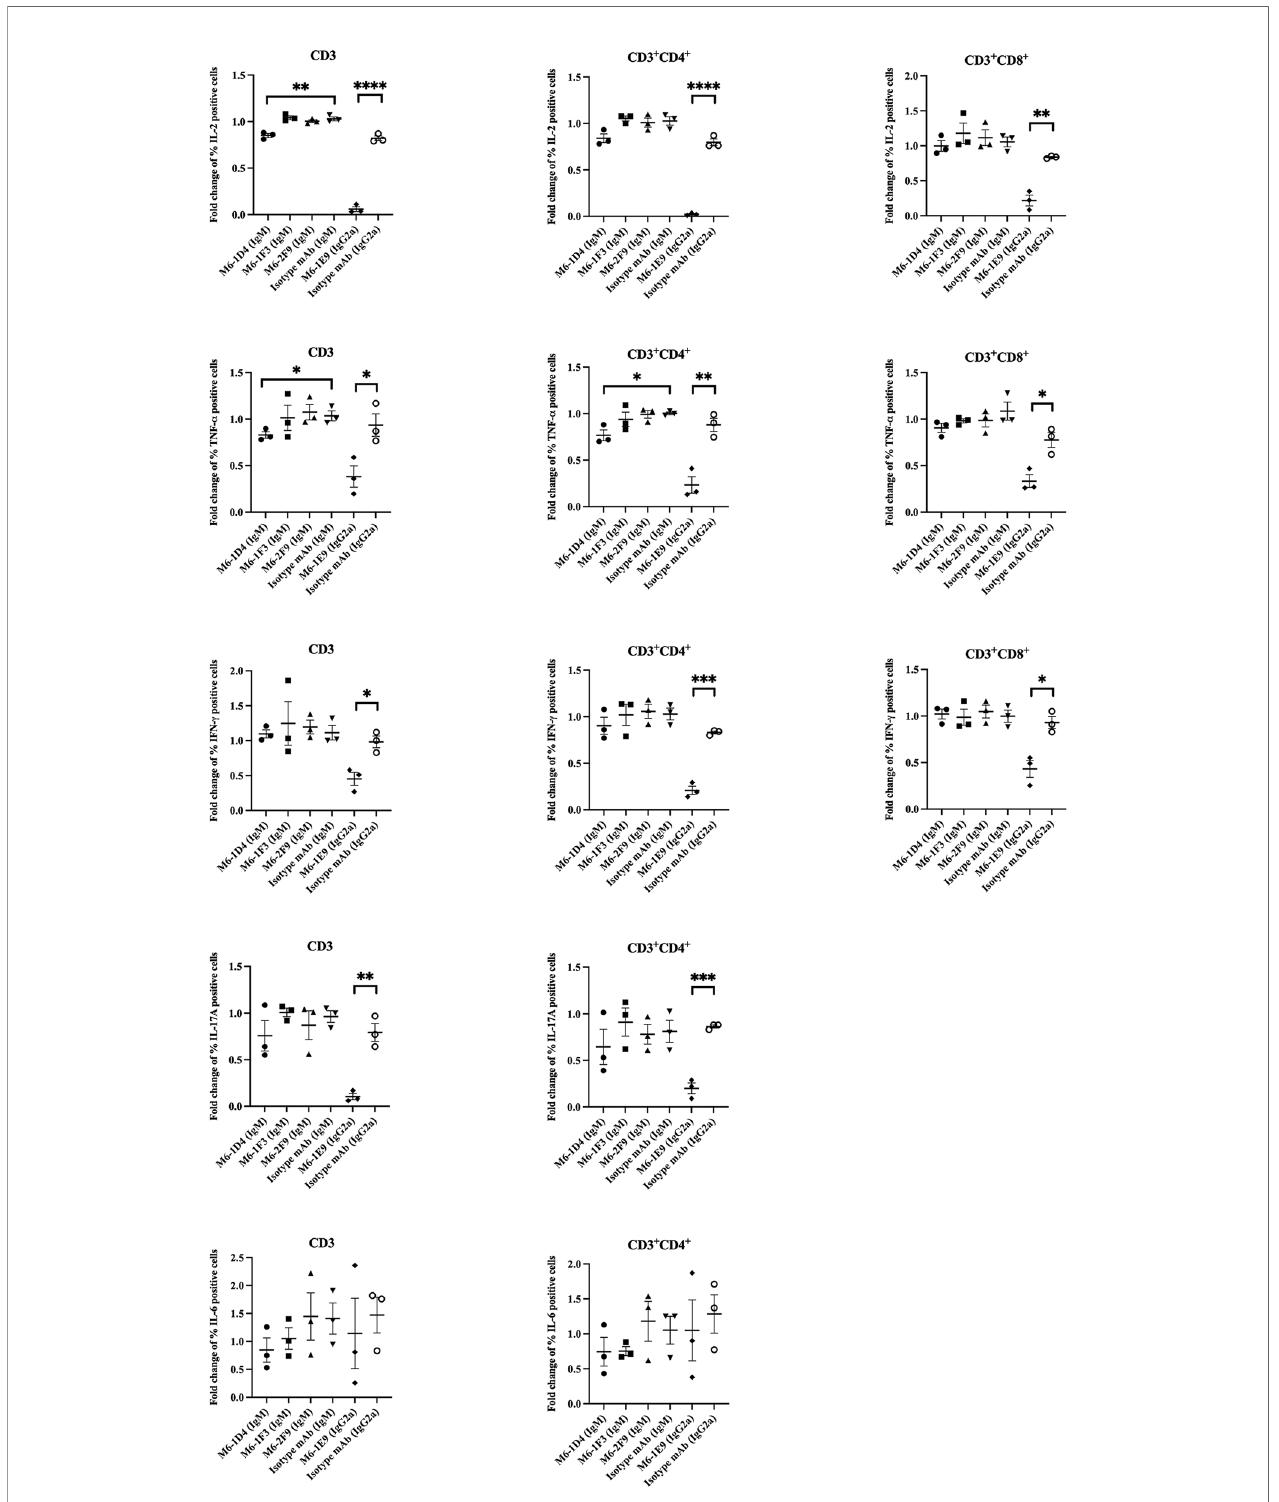
FIGURE 5 | Engagement of CD147 by anti-CD147 mAbsM6-1E9 and M6-1D4 inhibits cytokine production in T cells. PBMCs ( n = 3) were stimulated with anti-CD3 mAb in the absence (medium control) or presence of the indicated anti-CD147 mAbs or isotype-matched control mAbs. The frequency of cytokine-expressing cells (CD3, CD3 + CD4 + and CD3 + CD8 + T cells) was determined by fl ow cytometry and normalized to the medium control. Unpaired t-test was used for comparison. * represents p ≤ 0.05 and **p ≤ 0.01, ***P < 0.0005, ****P <